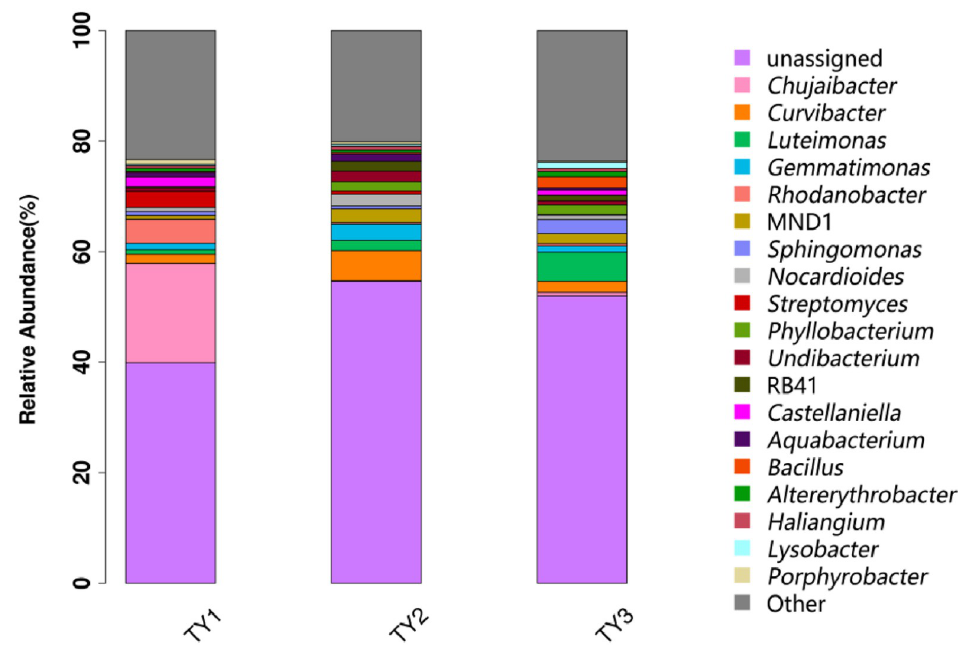
Fig 2. Comparison of bacterial classification at the genus level in soil of different planting patterns. TY1, Tomato continuous cropping; TY2, Eggplant-tomato rotation; TY3, Arrowhead-tomato rotation.